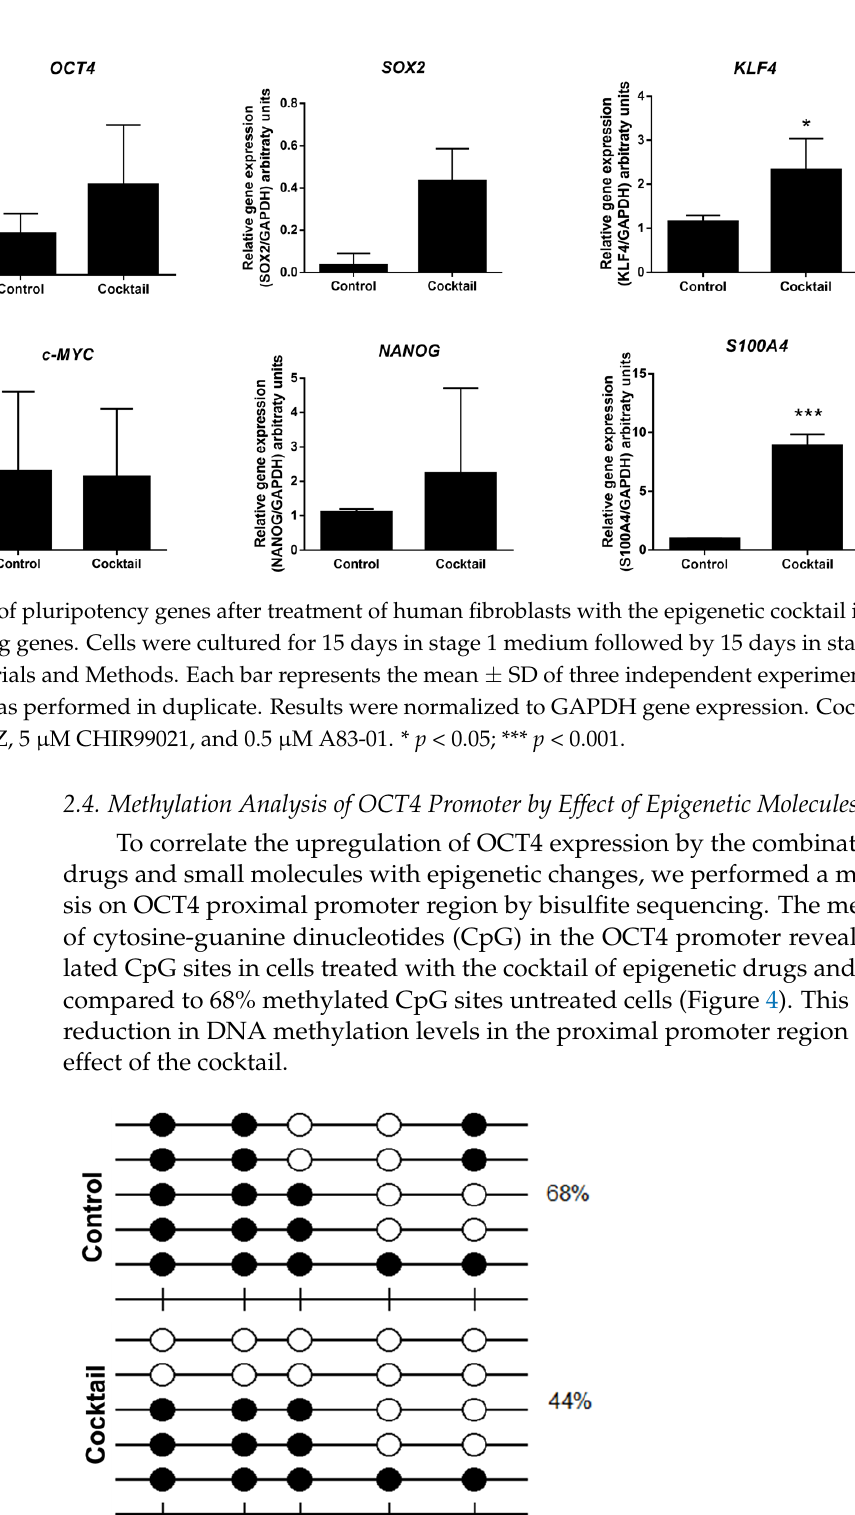
Molecules 2021 , 26 , x FOR PEER REVIEW 5 of 13 ( G ). Detection of the OCT4 ( H ), SOX2 (I), and NANOG ( J ) protein by immunofluorescence on hiPSC-like colonies at passage 5 counterstained with DAPI. Scale bars represent 100 µm for A–G and 50 µm for H–J. 2.3. Expression Analysis of Pluripotent Genes by Effect of Epigenetic Molecules We then asked whether the two-stage strategy, for 30 days, was capable of inducing the expression of pluripotency genes. Quantitative expression analysis of OCT4 and SOX2